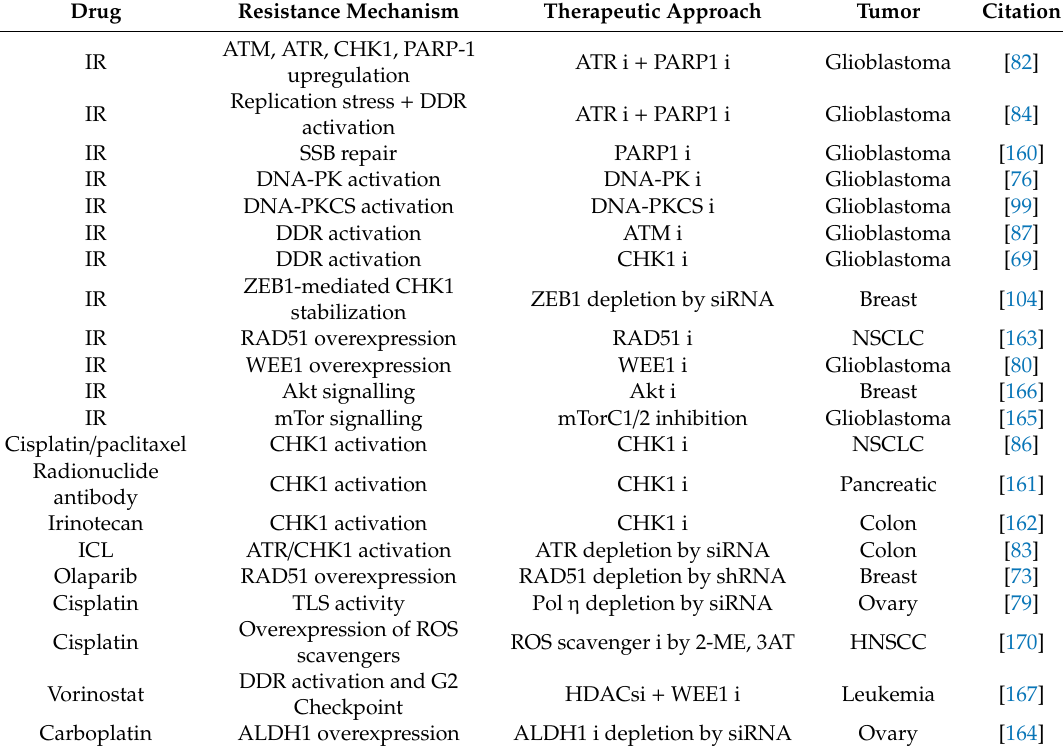
Table 1. Therapeutic approaches to specifically overcome radiation resistance in cancer stem cells (CSCs). The resistance mechanisms responsible in CSCs after irradiation or chemotherapy and the respective inhibitors used to selectively sensitize them are listed; NSCLC - non-small cell lung cancer; HDAC - histone deacetylases;